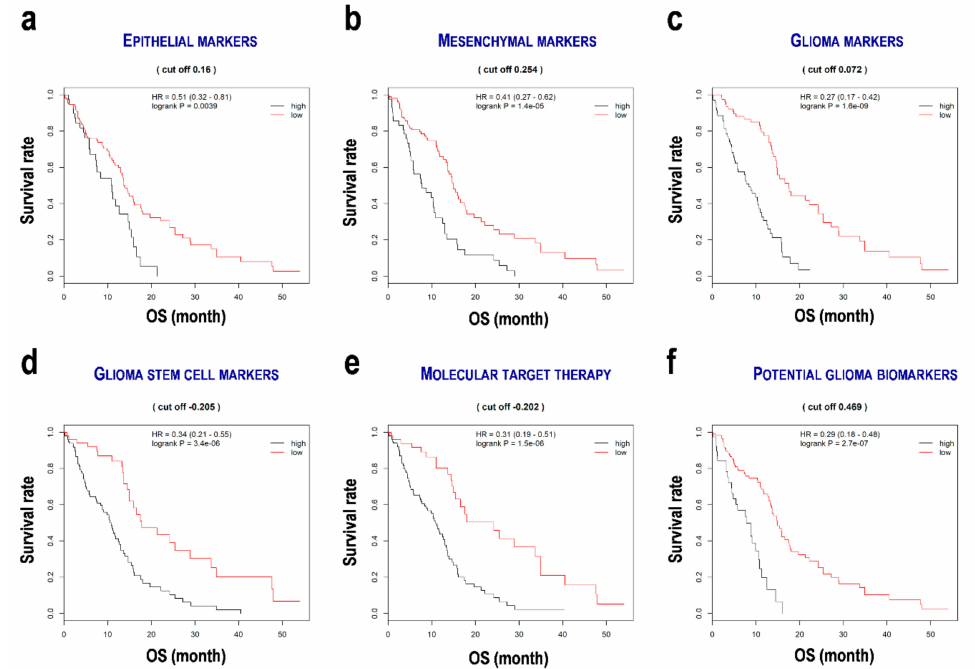
Figure 2. Survival distribution of the subgroups divided by the prognosis prediction formulae in the gene sets in glioblastoma. ( a ) Epithelial marker set. ( b ) Mesenchymal marker gene set. ( c ) Glioma marker gene set. ( d ) Glioma stem cell marker gene set. ( e ) Molecular target therapy gene set. ( f ) Potential glioma marker gene set. OS, overall survival; HR, hazard ratio; cut o ff score, a median score from a prognosis prediction formula. High and low denote the subgroups of the patients associated with the over and under median scores of the prognosis